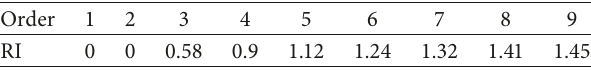
Table 2: Value range of judgment matrix.